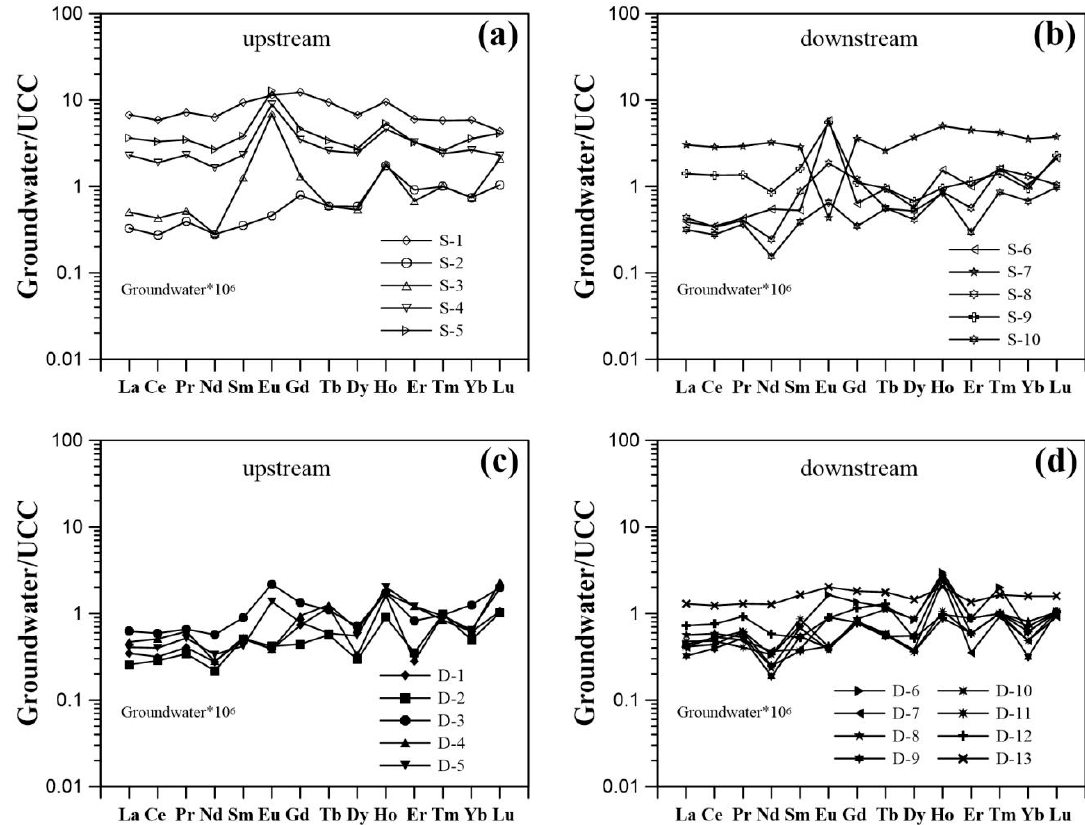
Figure 3. Groundwater upper continental crust (UCC)-normalized REE patterns of ( a ) upstream and ( b ) downstream shallow groundwater samples; and ( c ) upstream and ( d ) downstream deep groundwater samples (UCC values are from McLennan [36]).